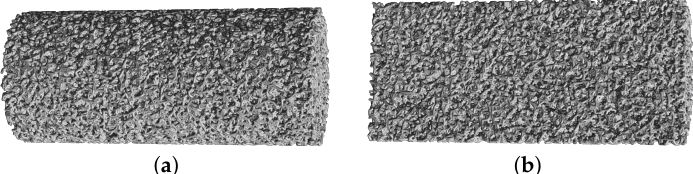
Figure 11. Bonded particle model (BPM) representation of cylindrical aerogel sample ( a ) and its cross-cut ( b ).